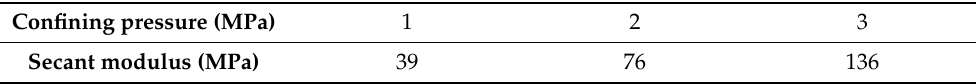
Table 3. Secant modulus of sediments containing spherical hydrates ( 𝑟 = 8.5𝑚𝑚 ).